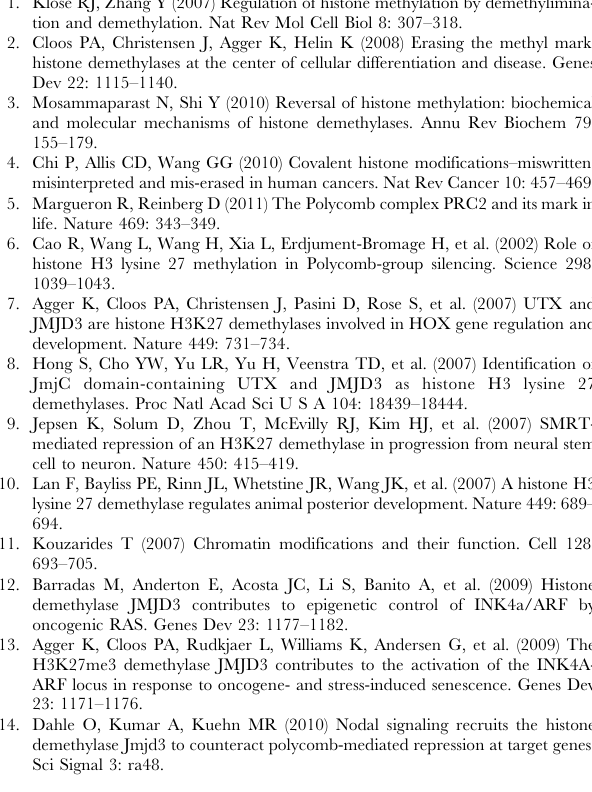
Figure S5 ChIP-Seq and ChIP-PCR analysis of lung marker and RRG genes. ( A ) ChIP-Seq analysis of H3K4me3 and H3K27me3 methylation in the regulatory and gene body regions of genes related to lung development. Scale= 2 kb. ( B ) ChIP-Seq analysis of H3K27me3 and H3K4me3 levels in several RRG- related genes in Jmjd3 KO and WT E17.5 lung tissues. Open boxes indicate 5 kb regions around TSS sites. Red arrows indicate